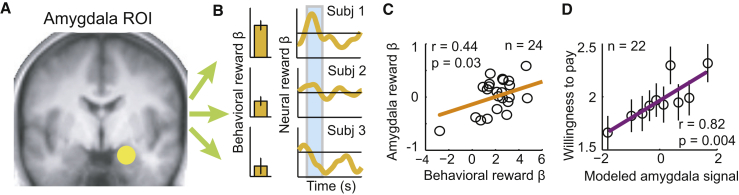
Across-Subject Relation between Amygdala Planning Activity and Individual Differences in Saving Strategy(A) Amygdala region of interest, defined in unbiased manner by leave-one-out method.(B) Illustration of analysis approach: regression of observed sequence lengths on factors reward type and interest rate resulted in subject-specific behavioral βs; a corresponding regression of amygdala activity during the planning phase (extracted from amygdala region of interest) resulted in subject-specific neural βs. Behavioral (left) and neural (right) βs for reward type (“reward β,” reflecting regression coefficients for high-fat versus low-fat content) are shown for three individual subjects. Neural βs are shown as time courses aligned to the onset of the planning phase cue. Blue shaded box indicates analysis period at the expected delay of the hemodynamic response.(C) Neurometric-psychometric comparison across subjects. Behavioral and neural reward βs are plotted for all subjects. Behavioral sensitivity to reward type matched amygdala sensitivity to reward type (significant with robust fit).(D) Amygdala planning activity modeled from individuals’ reward preferences predicted BDM bids. We fitted amygdala activity in the planning phase to reward type, as in (B), and used the resulting model of amygdala planning activity to predict willingness-to-pay bids from the auction-like (BDM) task using linear regression (robust fit). The plot shows means ± SEM for equally populated bins of modeled amygdala activity. This analysis was performed for the 22 subjects for whom BDM data were available.See also Figure S5.